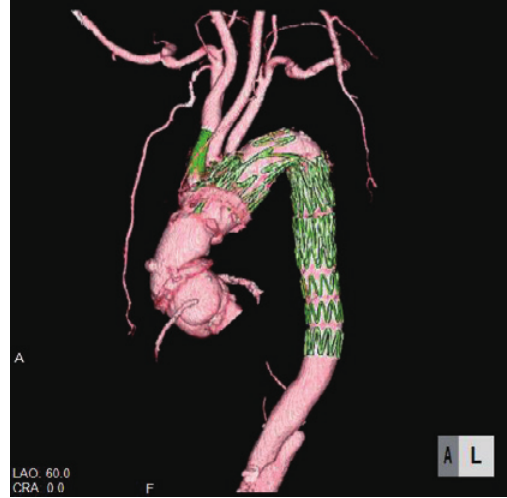
Figure 2. A post-operative computed tomography scan reveals no residual false lumen enhancement in the aortic arch, and the proximal portion of the zone 0 stent body is